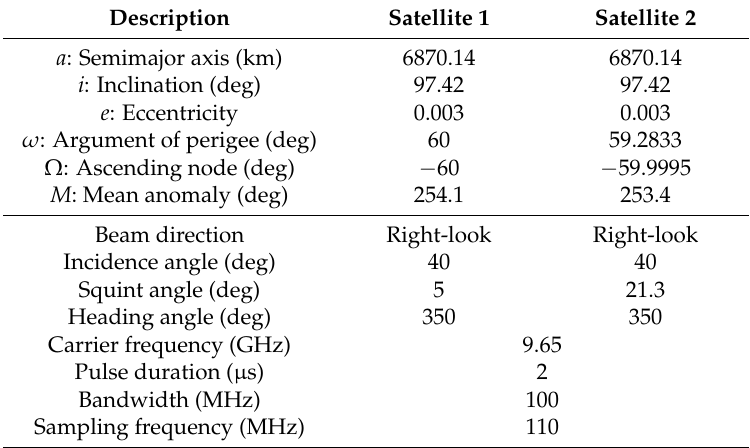
Table 2. Simulation parameters of SAR systems for 3-D deformation retrieval.